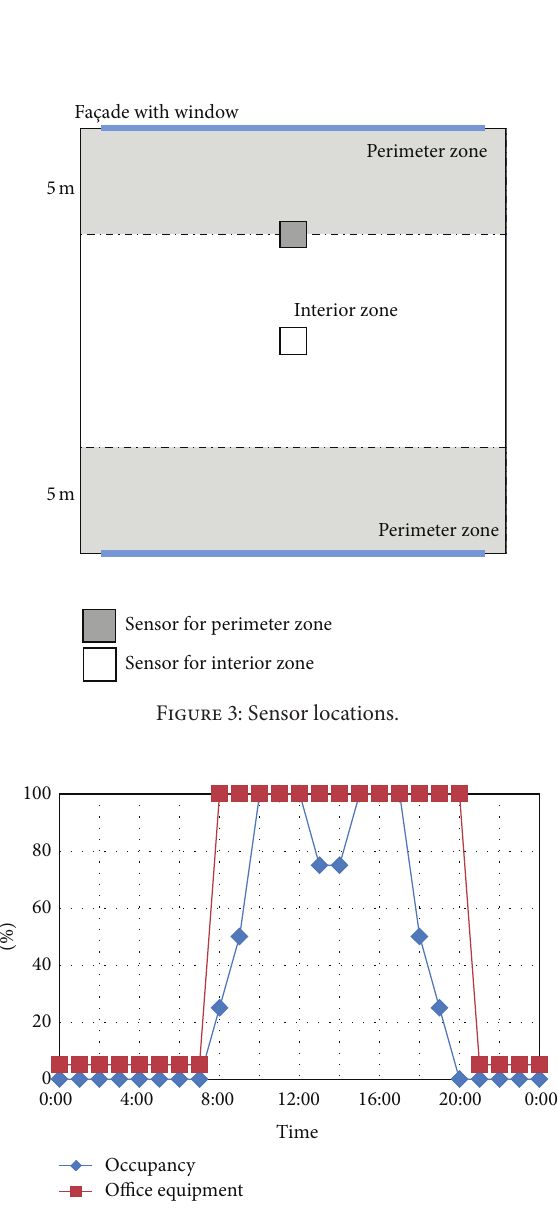
Figure 4: Schedule for internal heat load.